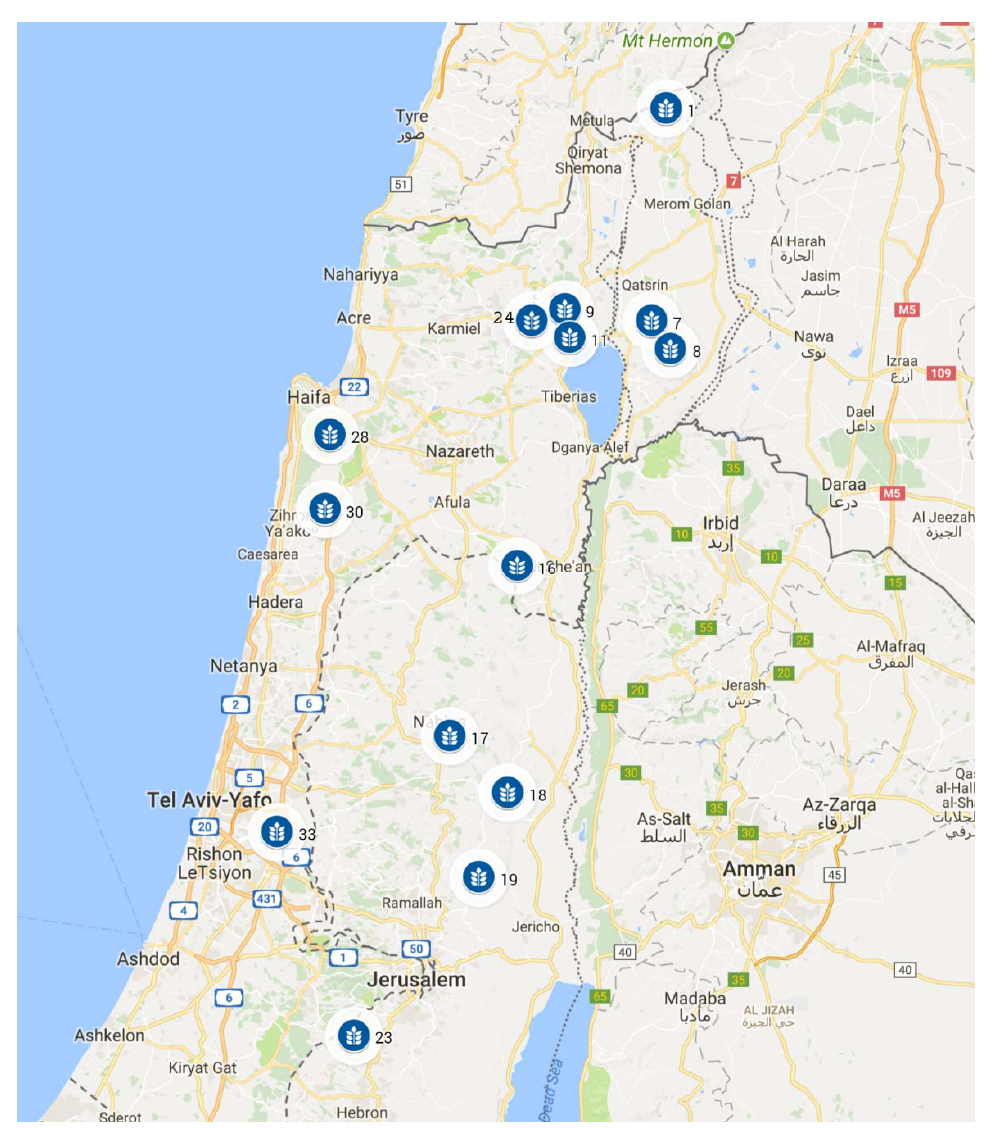
Figure 1. A map showing the geographic distribution of the 14 Israeli WEW populations. For names of the populations, see Table 1. For a map showing the Turkish West Diyarbakir population, see Nevo and Beiles [20].